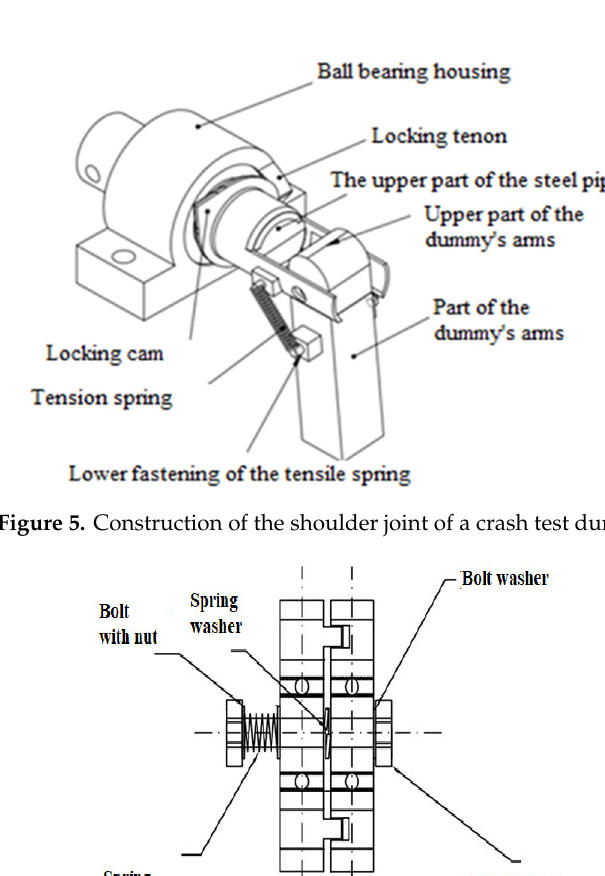
Figure 6. Construction of the elbow joint and wrist of a crash test dummy.